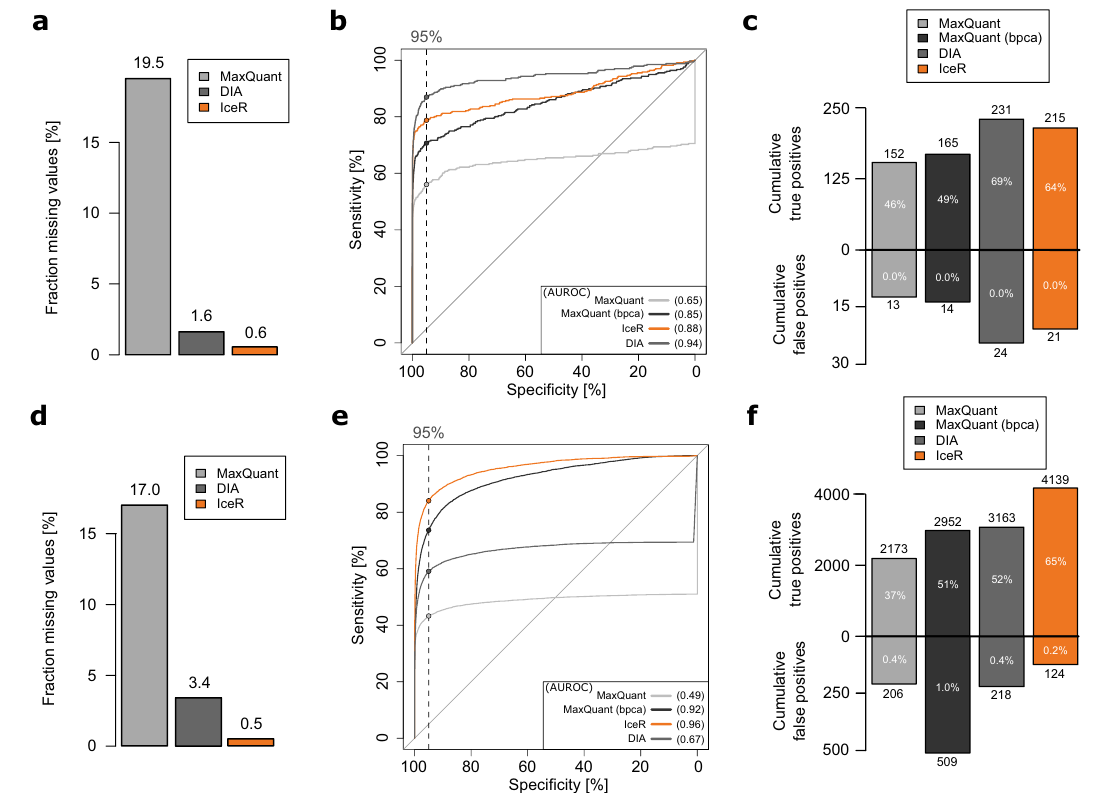
Fig. 4 IceR enables label-free DDA proteomics with DIA performance. a Fraction of missing values on peptide-level in MaxQuant (grey), DIA (red) and IceR (orange) results for a publicly available data set of 12 spiked proteins into a constant complex background at 8 concentrations ( n = 3). b Receiver operating characteristic (ROC) over all pairwise differential expression analyses on protein-level in MaxQuant (grey) and on peptide-level in IceR (orange) and DIA (red) data. Corresponding areas under the ROC (AUROC) are indicated. Dashed vertical line and respective dots represent observed sensitivity at 95% speci fi city per method. c Cumulative true and false-positive counts over all (28) pairwise DE analyses for MaxQuant (grey), DIA (dark grey) and IceR (orange). Percentages within bars indicate corresponding true positive and false-positive rates. d Fraction of missing values on peptide-level in MaxQuant (grey), DIA (red) and IceR (orange) results for a data set of an E. coli lysate spiked into a constant background at 6 concentrations ( n = 3). e Receiver operating characteristic (ROC) over all pairwise differential expression analyses protein-level in MaxQuant (grey) and on peptide-level in IceR (orange) and DIA (red) data. Corresponding areas under the ROC (AUROC) are indicated. Dashed vertical line and respective dots represent observed sensitivity at 95% speci fi city per method. f Cumulative true and false positives over all (15) pairwise DE analyses for MaxQuant (grey), DIA (dark grey) and IceR (orange). Percentages within bars indicate corresponding true positive and false-positive Fig. 8a, b). The fraction of missing values on peptide-level (19.5% in MaxQuant) could be reduced to 1.6% in DIA and, remarkably, to 0.6% in IceR data (Fig. 4a). Comparison of observed CVs on peptide-level between MaxQuant, DIA and IceR showed the highly reproducible quanti fi cation in DIA data. Median CV could be reduced from 16% in MaxQuant data to 8% in DIA data, along with an increase in available quanti fi cation in a 250% increase in available quanti fi cation events compared to MaxQuant. Since this included more variable low abundant (17.5%). When focusing on con fi dently quanti fi ed peptide